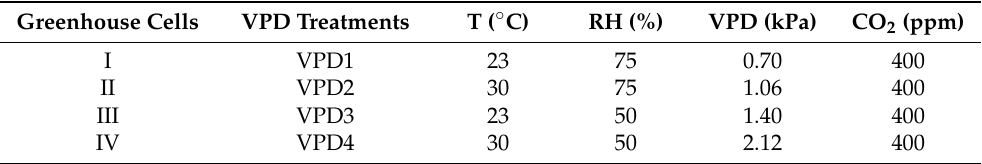
Table 3. Set points for VPD treatments in greenhouse